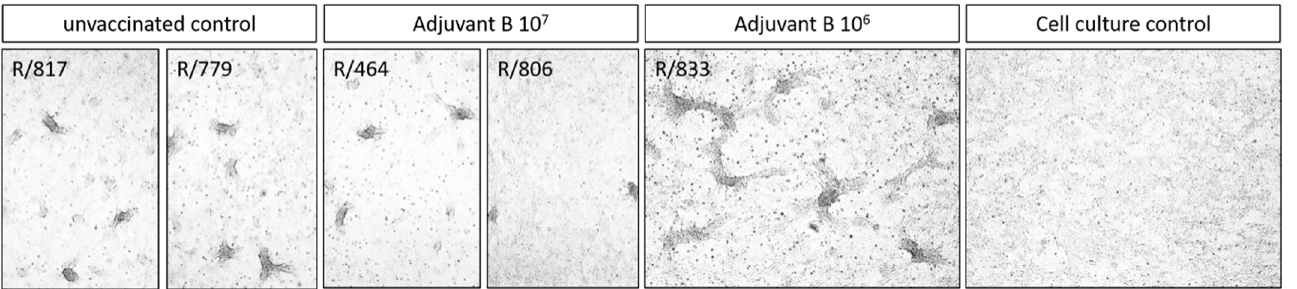
Figure 10. Virus isolation from skin samples obtained from skin nodules of Adjuvant B-vaccinated cattle that were positive for Capripox virus genome. Skin samples were homogenized and incubated on susceptible MDBK cells for 7 days. Afterwards, cytopathic effect was analyzed using a light microscope. Virus isolation was successful of all skin samples that were tested positive for Capripox virus genome.